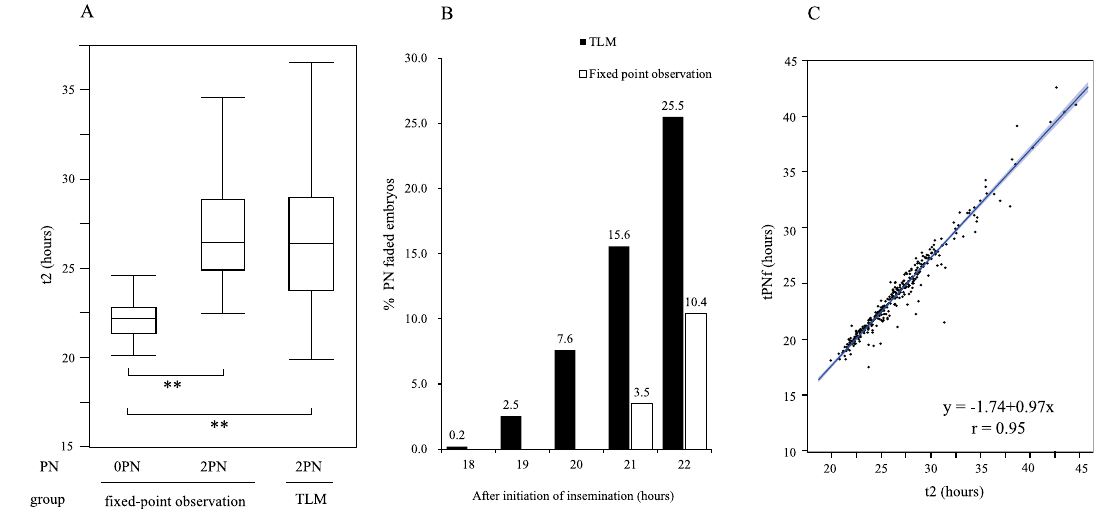
Figure 1. Time from insemination to first cleavage, the proportion of PN faded embryo, and correlation between t2 and time of PN fading. ( A ) The time from the initiation of insemination to first cleavage (t2) in 0PN- and 2PN-derived embryos in the fixed-point observation group and 2PN-derived embryos in the TLM group (n = 12, 82, and 339, respectively). The 0PN-derived embryos had a significantly earlier t2 than the 2PN-derived embryos in both groups. Data were analyzed using the Wilcoxon test. ** P < 0.0001. ( B ) The proportion of PN faded embryo after 18–22 h from insemination. In the TLM group, the proportions of PN faded embryo at 18–22 h from insemination were 0.20% (1/514, 2PN = 1), 2.5% (12/154, 2PN = 12, 3PN = 1), 7.59% (39/514, 2PN = 36, 1PN = 2, 3PN = 1), 15.6% (80/514, 2PN = 72, 1PN = 3, 3PN = 4, 4PN or more = 1), and 25.5% (131/514, 2PN = 115, 1PN = 4, 3PN = 9, 4PN or more = 3), respectively. In the fixed-point observation group, proportions of PN faded embryos were 3.6% (5/139, 2PN = 5) at 21 h after insemination and 10.8% (15/139, 2PN = 15) at 18–22 h post-insemination. ( C ) The correlation between t2 and time of PN fading (tPNf) of 2PN-derived embryos in the TLM group (n = 331). There was a significant positive correlation observed between t2 and tPNf. PN pronuclei; TLM time-lapse monitoring.